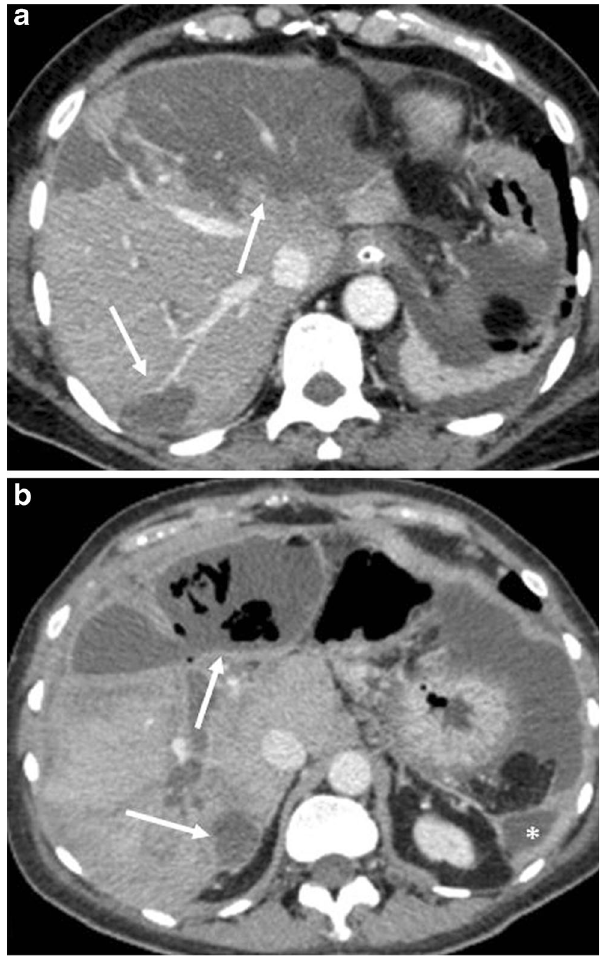
Fig. 20 Hepatic infarction. a CT image shows multiple hypodense and hypovascular areas of infarction (white arrows) following a pancreaticoduodenectomy. b CT image 4 weeks later in the same patient. The areas of infarction show a thickened and enhancing wall with multiple air bubbles within (white arrows), findings consistent with hepatic abscesses. Another abscess is visible at the level of the left lateroconal fascia